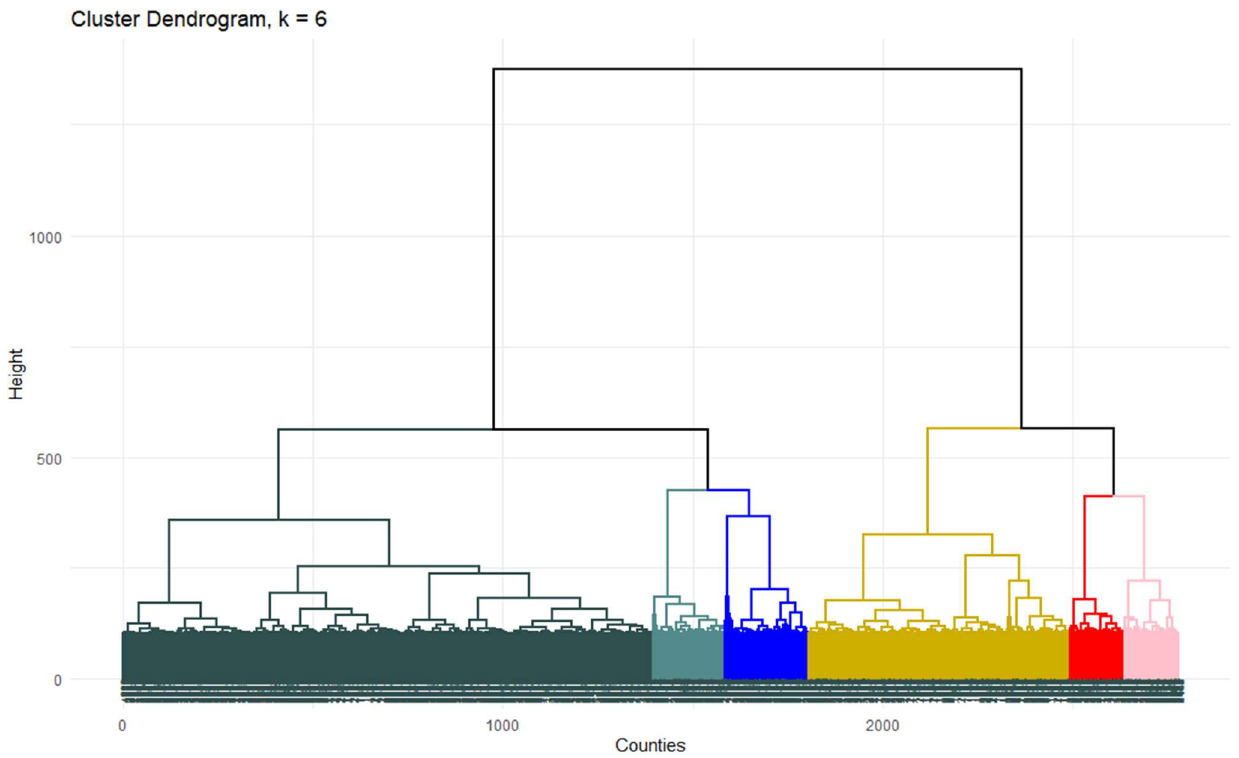
Figure 2. Cluster dendrograms.